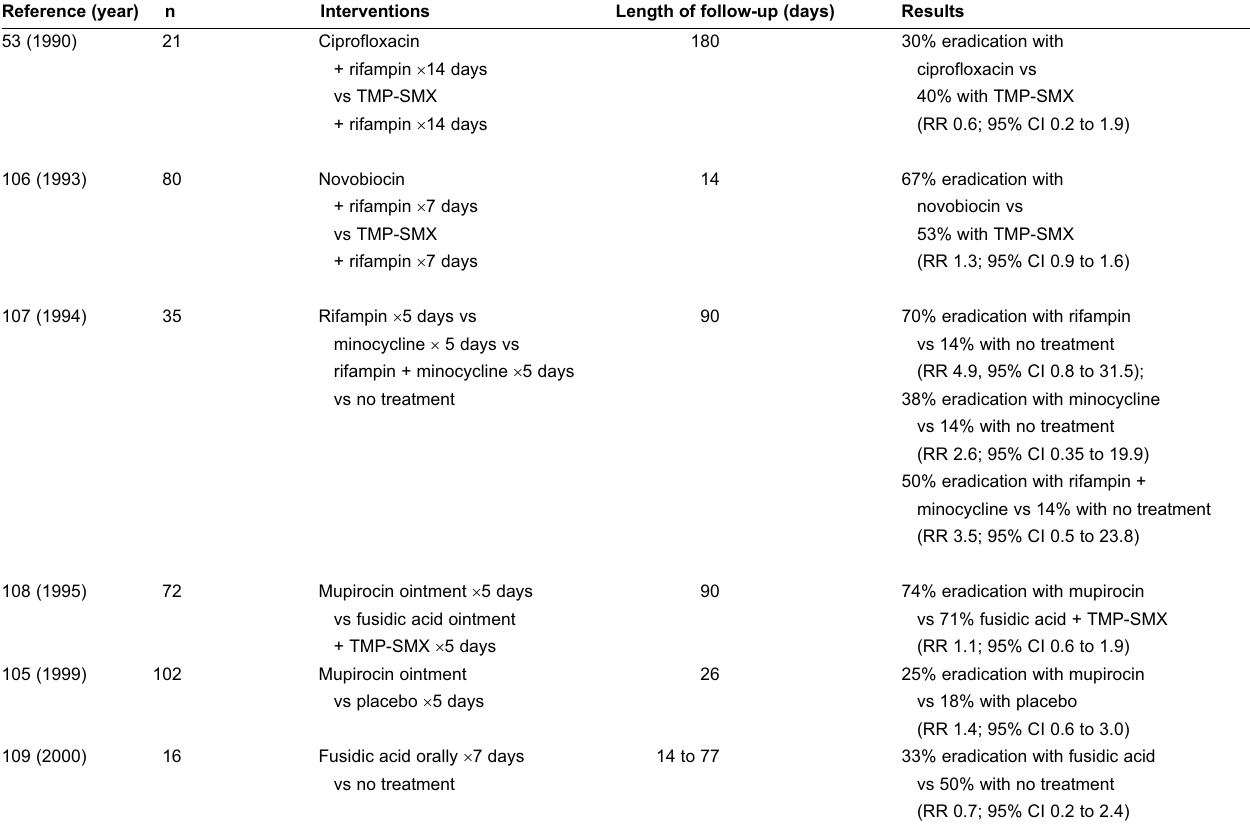
TABLE 2 Summary of characteristics and results of clinical trials of antimicrobial agents used for eradication of methicillin-resistant Staphylococcus aureus (MRSA)